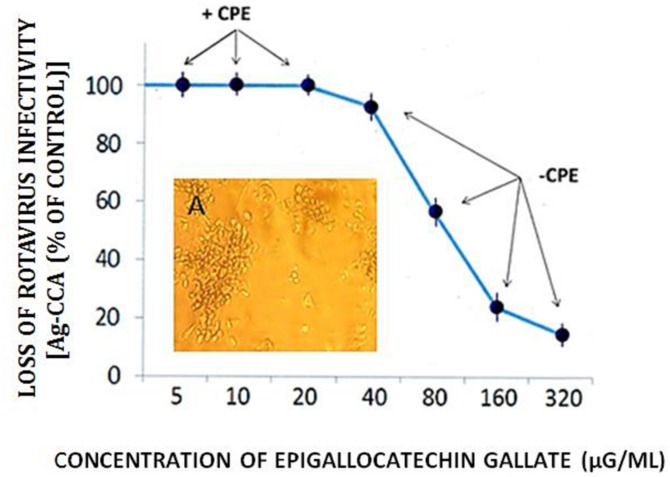
Effect of EGCG on RTV infectivity in MA-104 host cell cultures. RTV was treated with increasing concentrations of EGCG, incubated in suspension for 60 min., followed by inoculation of 25 μl of the virus-catechin complex into microtiter plates (96-well cluster plates) containing MA-104 cells in monolayer culture. After 5 days in culture, viral capsid antigen levels were quantitatively determined. The appearance (or absence) of the cytopathic effect (CPE) was recorded as well. Replicate cultures were monitored for a period of 8 days, showing no differences in the appearance of the RTV CPE. Data points based on spectrophotometric readings represent the mean ± SE of the means. P < 0.05 was assumed statistically significant. 160 vs. 320 μg/ml: P = 0.24. Insert A Photomicrograph of the RTV CPE shows a breakage of cell monolayer with the appearance of cellular rounding and clumping (see
Lipson, 1992). Mock infected cell cultures remained intact for the duration of the experiment (not shown).